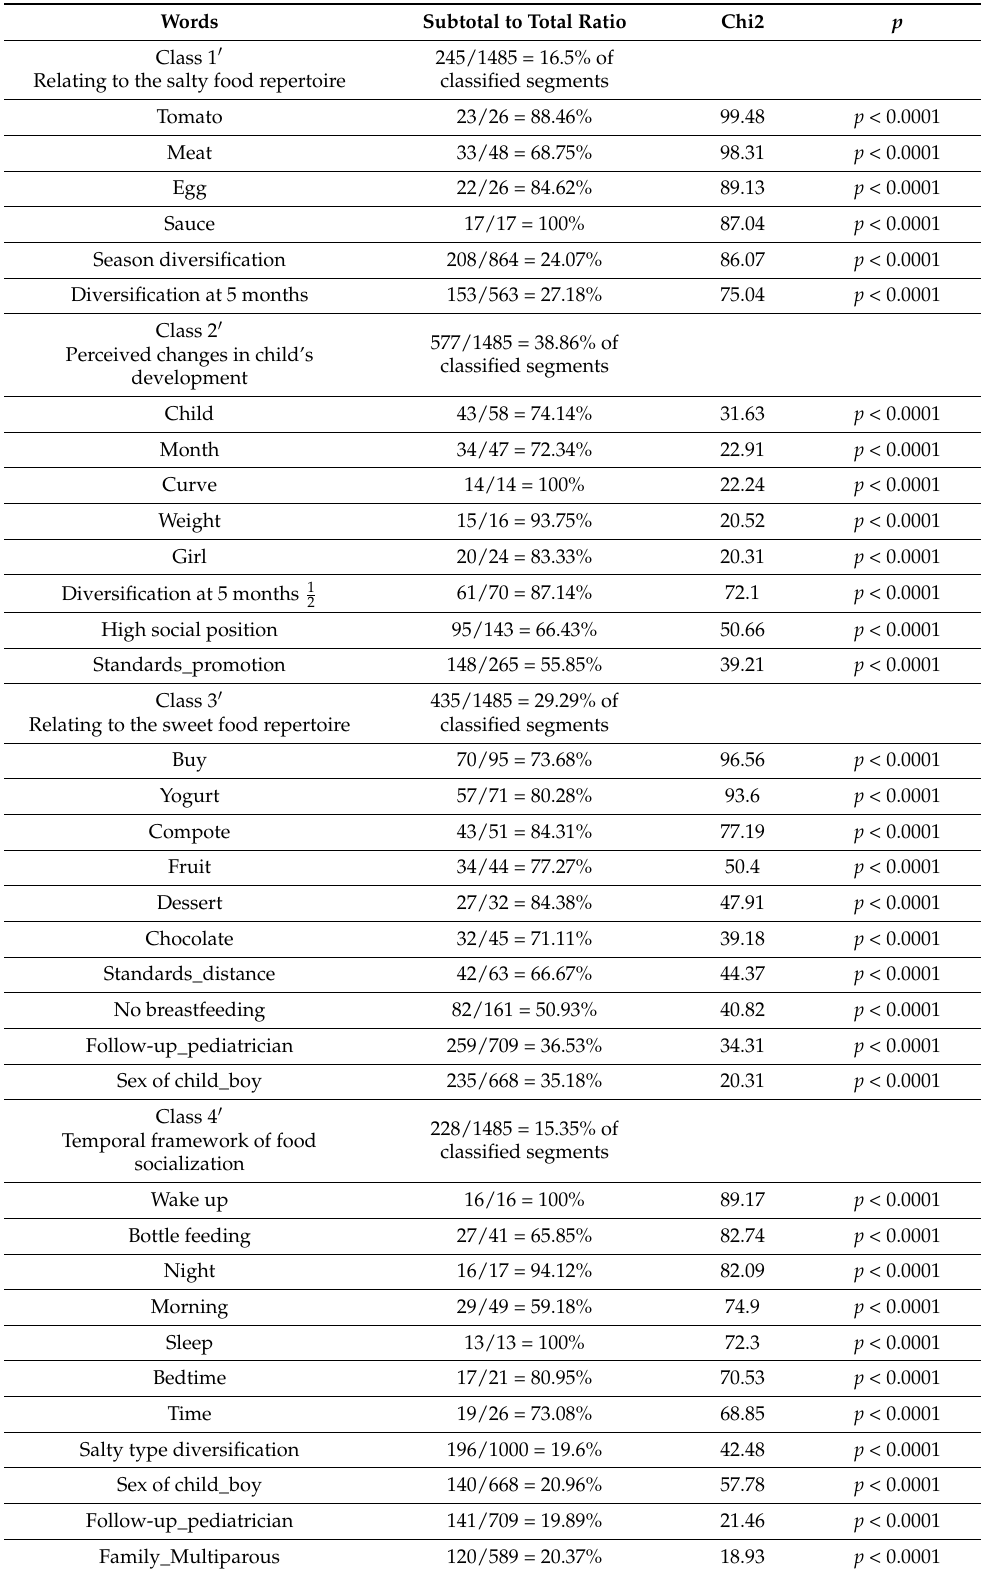
Table A3. Classes, ratio, Chi2 and p for parents in the second interview: first associated